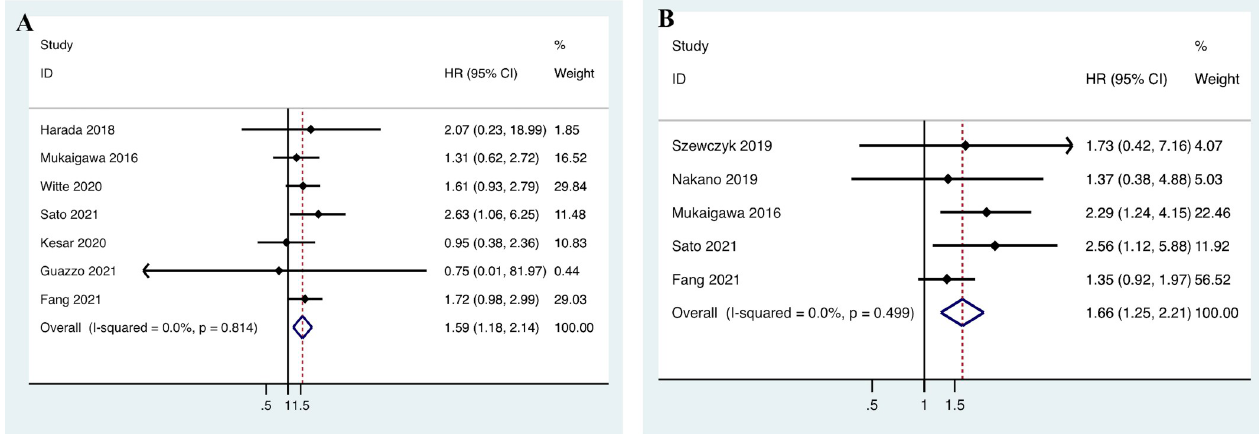
Fig 3. Forest plot for the association between programmed cell death ligand 1 (PD-L1) expression and (A) the overall survival (OS); and (B) the disease-free survival (DFS) of salivary gland carcinoma (SGC) patients. HR, hazard ratio; CI: confidence interval.